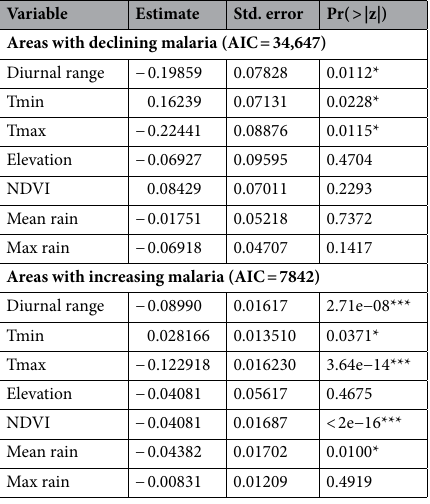
Table 1. Regression model of environmental variables and malaria. Signif. codes: 0 ‘***’ 0.001 ‘**’ 0.01 ‘*’ 0.05 ‘.’ 0.1 ‘ ’ 1.